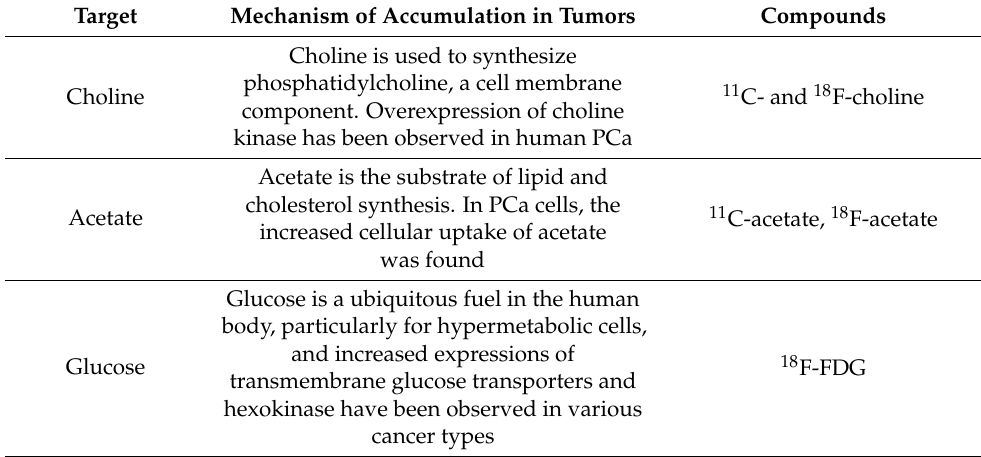
Table 1. The radioisotope-based imaging agents for